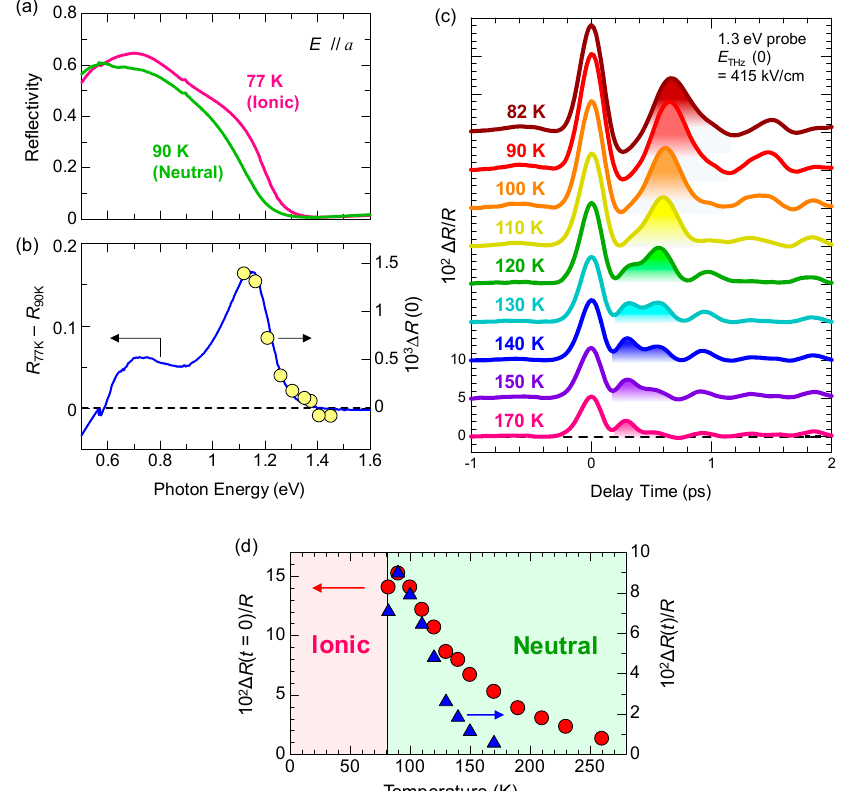
Figure 25. Temperature dependence of transient optical-reflectivity change by a terahertz electric field in the paraelectric N phase of TTF-CA [42]. ( a ) Polarized reflectivity spectra in the CT transition region at 90 K (the neutral phase) and at 77 K (the ionic phase); ( b ) Probe energy dependence of terahertz-electric-field-induced reflectivity changes at the time origin ∆ R ( 0 ) / R (yellow circles). The blue line shows the differential reflectivity spectrum, [ R I (77 K) − R N (90 K)]; ( c ) Time evolutions of terahertz-field-induced reflectivity changes ∆ R ( t ) / R at various temperatures. Shaded areas show second peaks; ( d ) Temperature dependence of reflectivity changes ∆ R ( t ) / R at the first peak (the time origin) (circles) and the second peak (triangles).